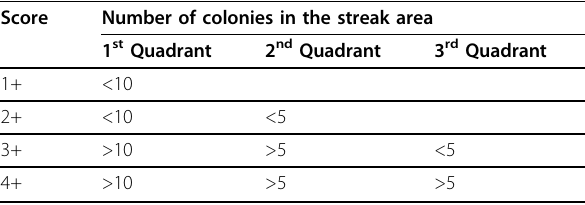
Table 2 Semi-quantitative analysis scoring system for microbiological